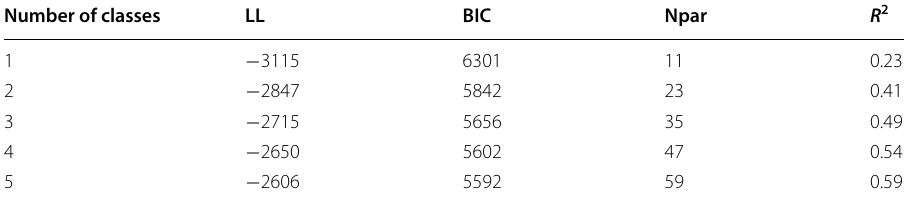
LL log likelihood, BIC =